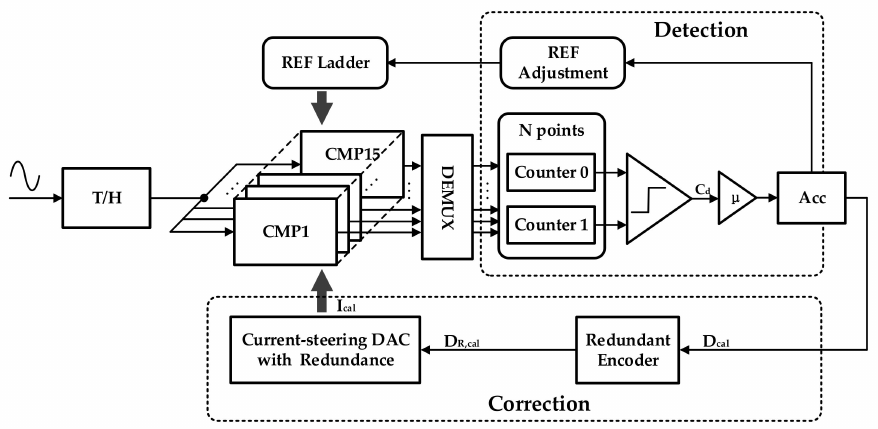
Figure 6. Overall block diagram of the proposed statistics-based o ff set